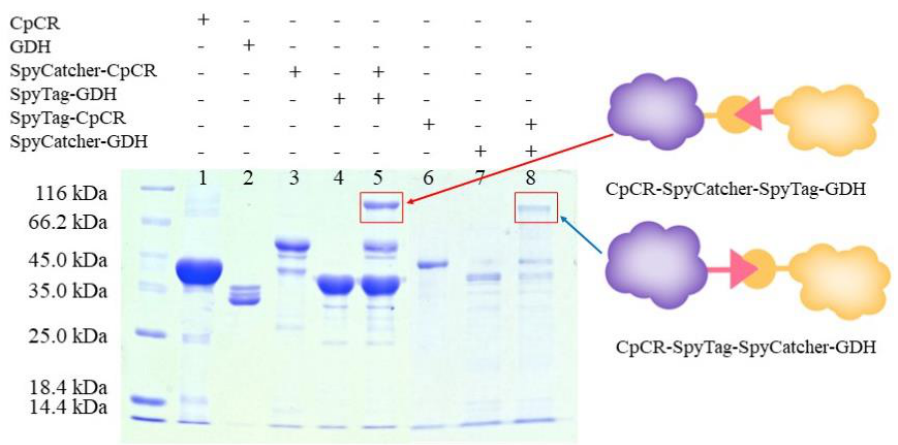
Figure 7. SDS-PAGE analysis of cross-linking reaction of fusion enzymes; Lane 1: CpCR (41 kDa); Lane 2: GDH (32 kDa); Lane 3: SpyCatcher-CpCR (54.5 kDa); Lane 4: SpyTag-GDH (34.1 kDa); Lane 5: